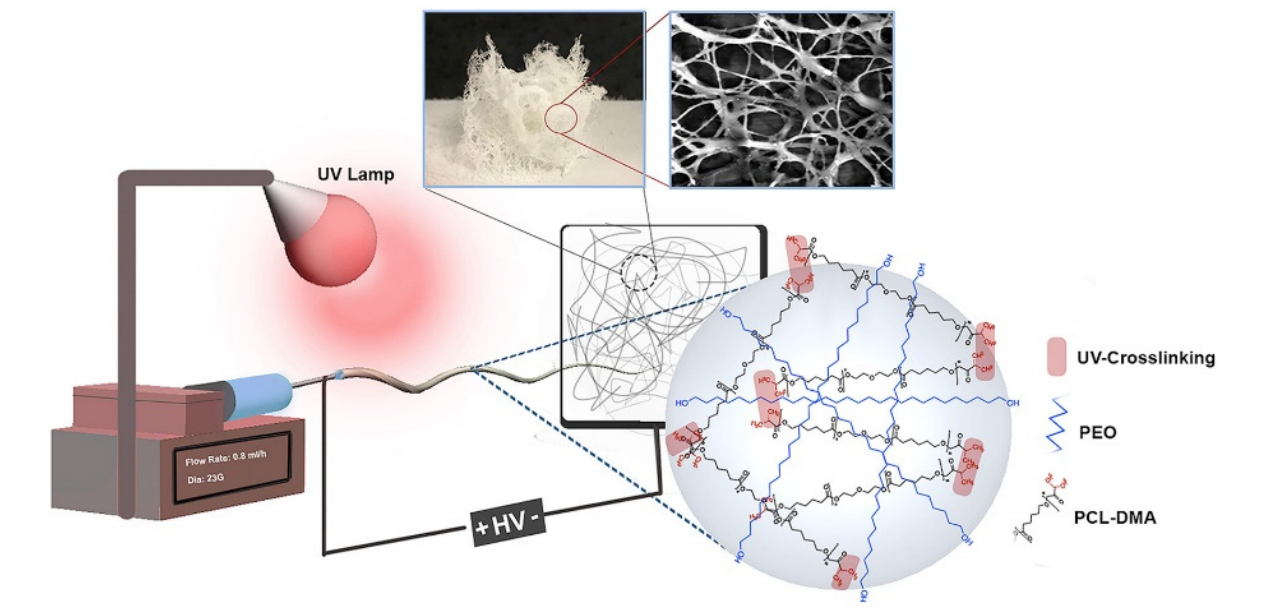
Figure 15. Representation of the sponge-like 3D scaffold [150].